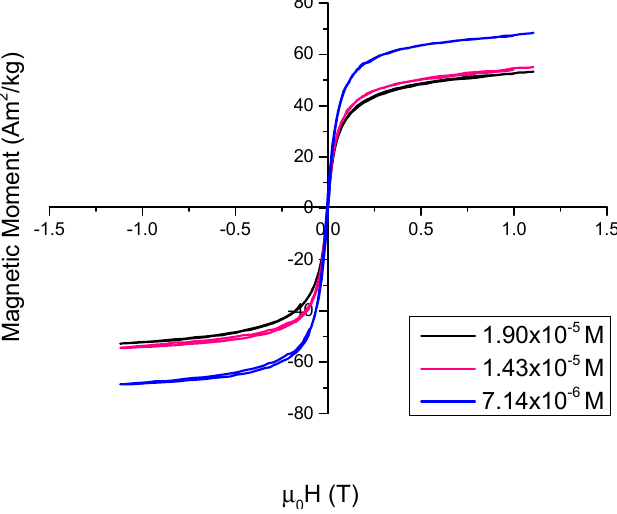
Figure 2. VSM (Vibrating Sample Magnetometry) curves of each concentration of immobilized PSS-stabilised Fe 3 O 4